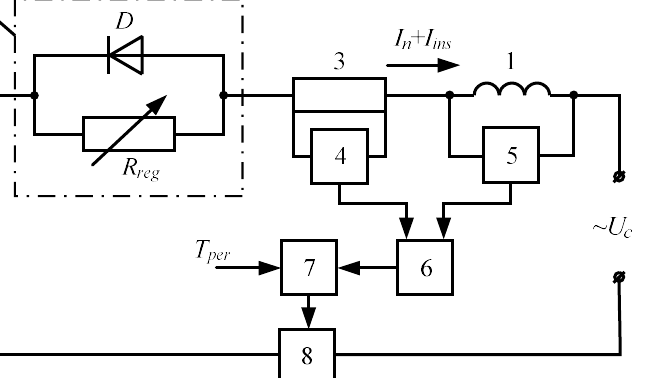
Figure 1. A schematic block diagram of a thermal protection device generating an instrumental current from the operating AC: 1, thermal sensor; 2, DC input block; 3, measuring shunt; 4, block for measuring the value of the instrumental DC I ins ; 5, block for measuring the value of voltage drop on the temperature sensor caused by the current I ins ; 6, computing block; 7, threshold switch; and 8, executive unit.